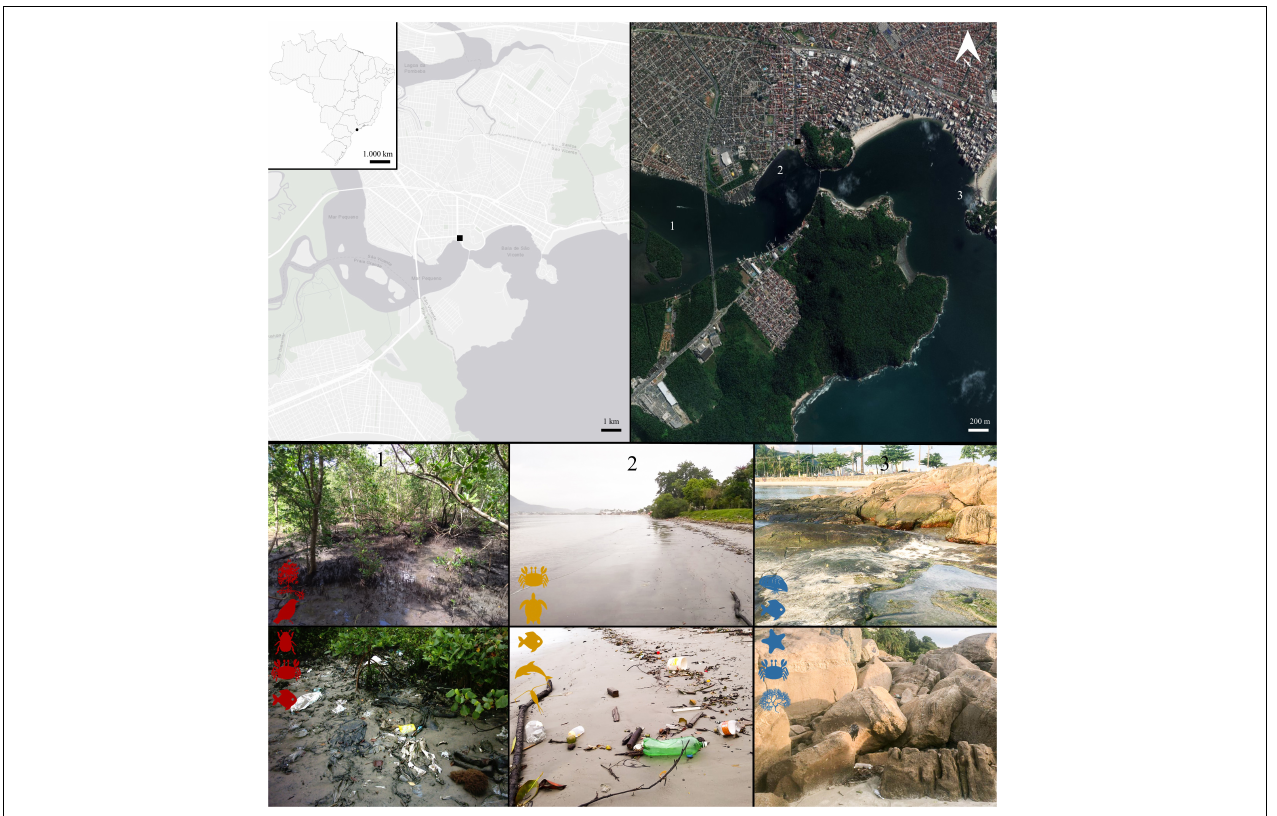
FIGURE 1 | Map of São Vicente (shown as black circle), São Paulo, Brazil, highlighting the school’s location (black square) and surrounding coastal and marine habitats which were discussed during the project: mangroves (1), sandy beaches (2), and rocky shores (3). Contrasting states of pollution are show for each habitat (top – clean; bottom – polluted). Main fauna and flora groups explored in our activities are represented as vectors for each habitat (top to bottom). Mangroves (red): mangrove trees, birds, insects, crustaceans and fishes; sandy beaches (yellow): crustaceans, marine reptiles, fishes, marine mammals and zooplankton; rocky shores (blue): mollusks, fishes, echinoderms, crustaceans and algae. All vectors are released under the Creative Commons CC0